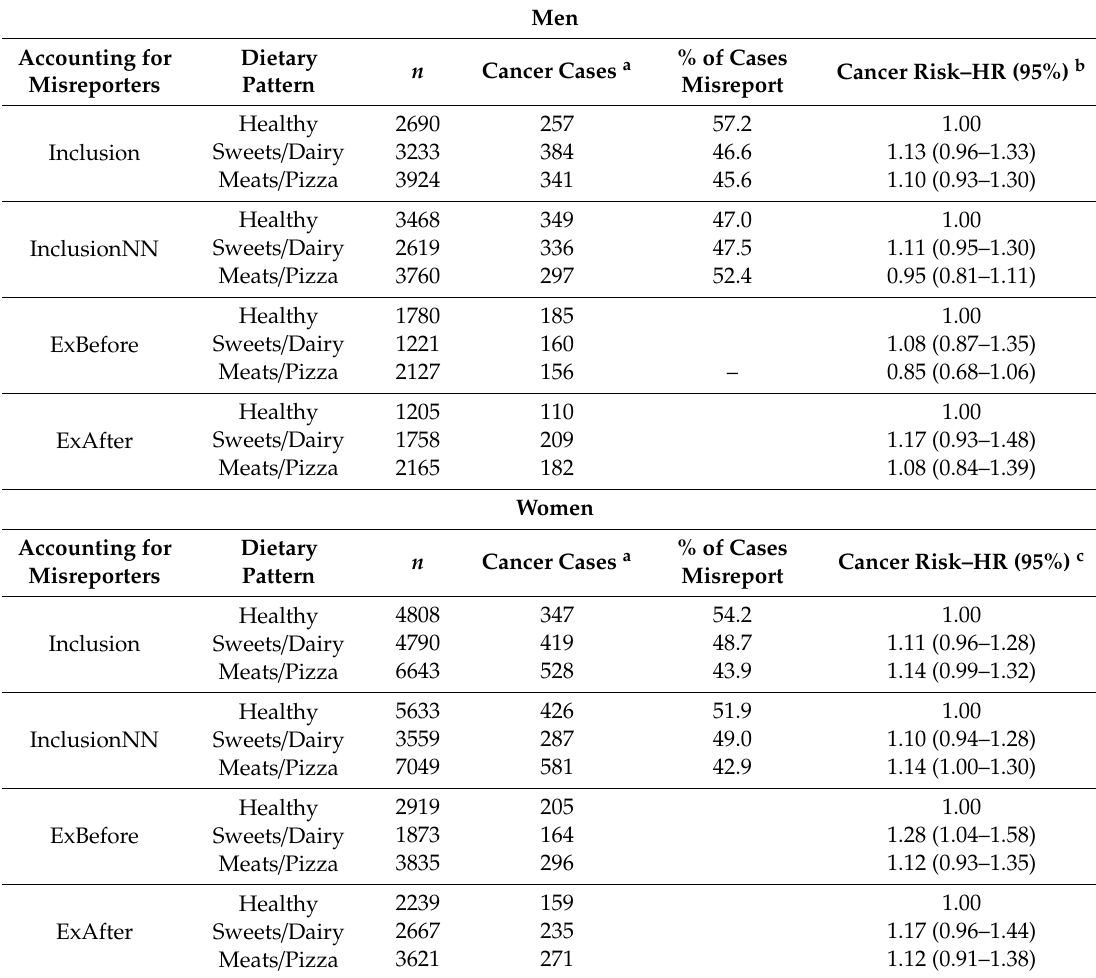
Table 4. Multivariable Cox proportional hazards ratio of the incidence of All-Cancers for dietary patterns identified by cluster analysis and stratified by four methods to account for